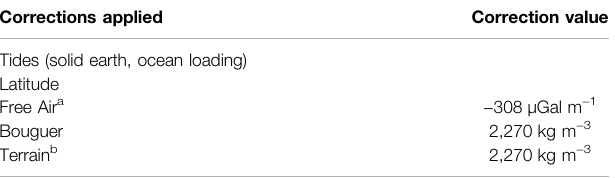
TABLE 2 | Gravity data